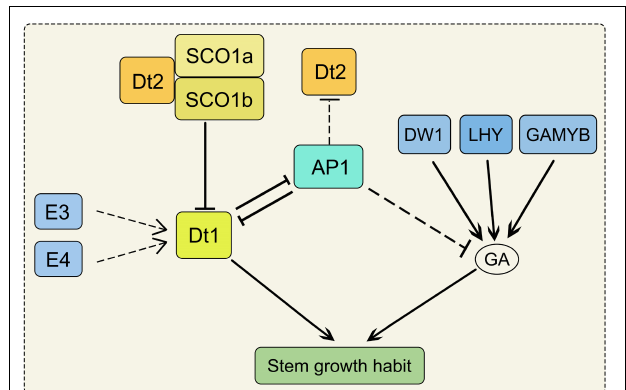
FIGURE 1 | The regulation pathway of stem growth habit in soybean. SOC1a and SOC1b complex interacts with Dt2 to repress the transcription of Dt1 . AP1 can inhibit Dt2 expression. Dt1 and AP1 form a suppressive regulatory feedback loop. AP1 may negatively regulate the expression of the GA metabolic pathway-related genes. Phytochromes E3 and E4 induce Dt1 transcription indirectly. Both of the SOC1, AP1, E3, E4 and Dt2 impact on the stem growth habit through Dt1 in soybean; DW1, LHY, GAMYB could regulate the stem growth habit through GA biosynthetic pathway. SOC1, SUPPRESSOR OF OVEREXPRESSION OF CONSTANS1; AP1, APETALA1; E3 and E4, phytochromes E3 and E4; DW1, a dwarf gene encodes an ent -kaurene synthase; LHY, LATE ELONGATED HYPOCOTYL; GA,